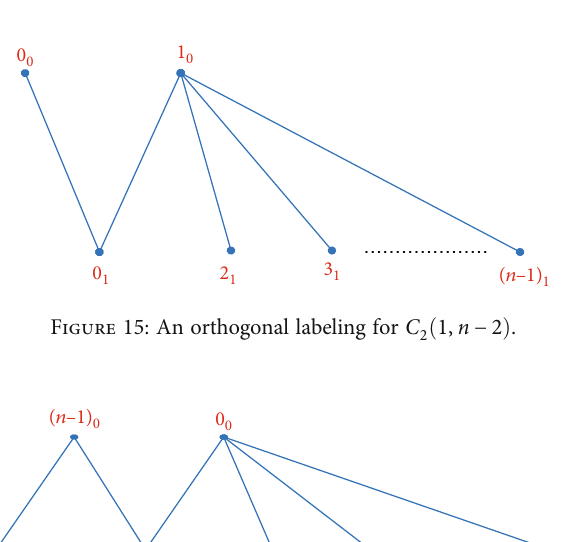
Figure 16: An orthogonal labeling for C